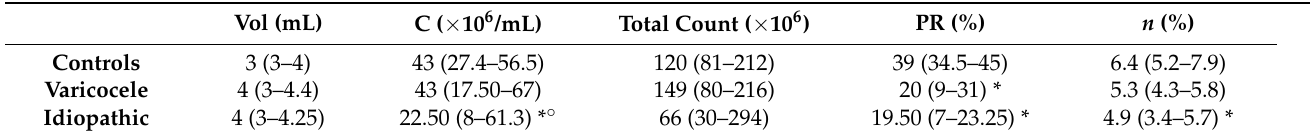
Table 1. Median and interquartile range of the main seminal parameters used for evaluation of male infertility according to WHO in the three groups. Vol = volume (mL), C = concentrations of spermatozoa in seminal fluid ( × 10 6 /mL), Total Count = Vol ∗ C ( × 10 6 ), PR = progressive forms (%), n = normal forms (%).